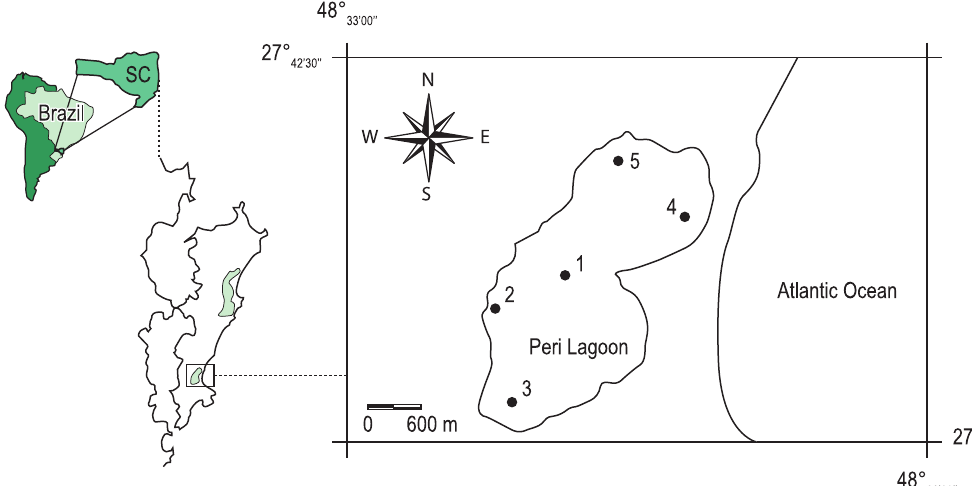
Figure 1. The map of the sampling sites in Peri lagoon (27° 44’ S and 48° 31’ W), southern region of Florianópolis Island (Santa Catarina,